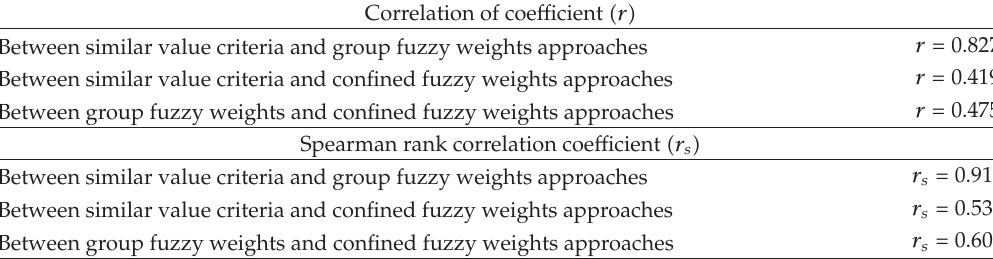
Table 8: Analysis of correlation for e ffi ciency and rank of DMUs.